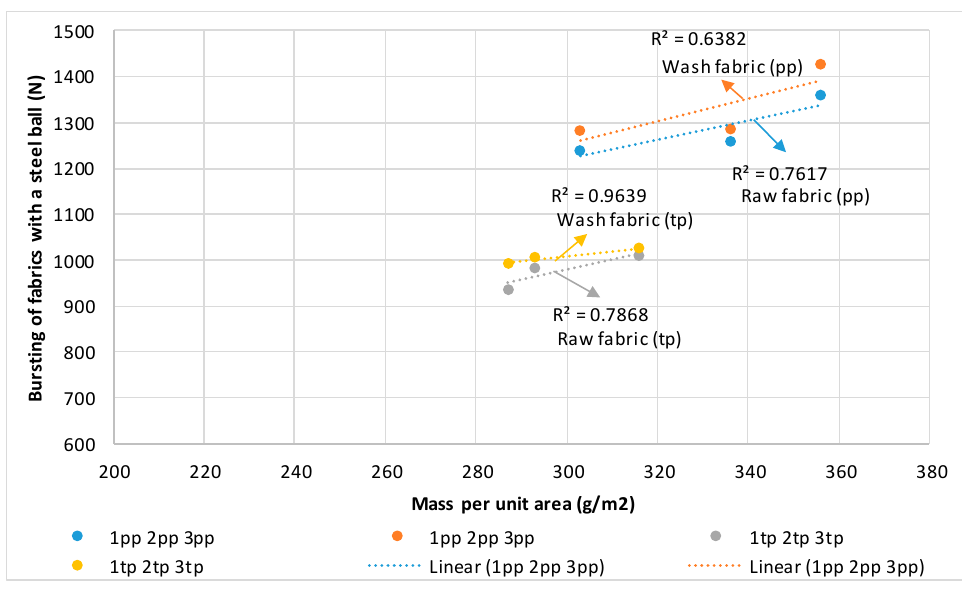
Figure 12. Directions of the coefficient of determination and regression between the bursting of woven fabrics (N) and mass per unit area (g/m 2 ).